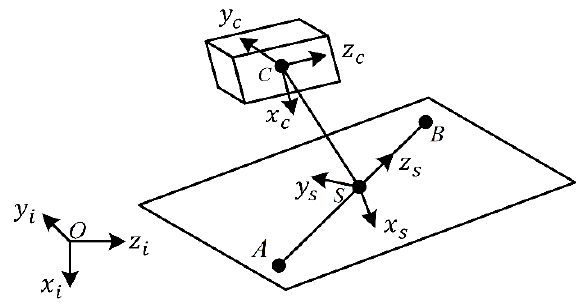
Figure 2. Settings of the coordinate systems.